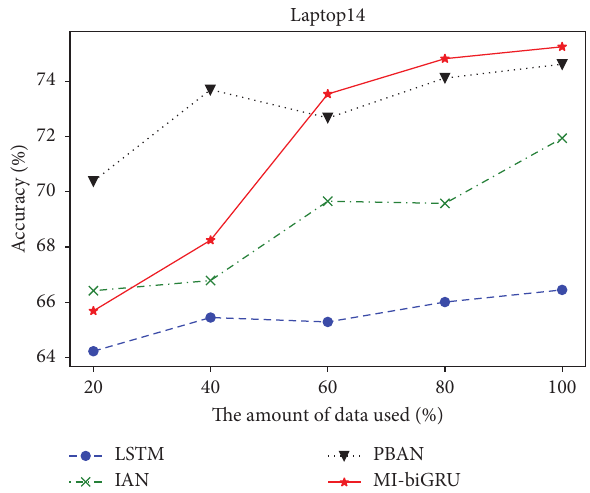
Figure 5: Accuracy trend of baseline models in laptop domain.